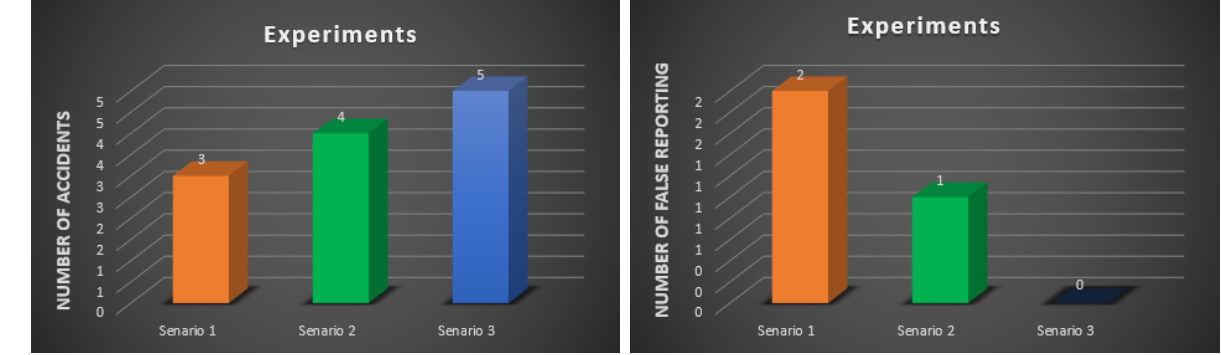
Figure 8. Simulation